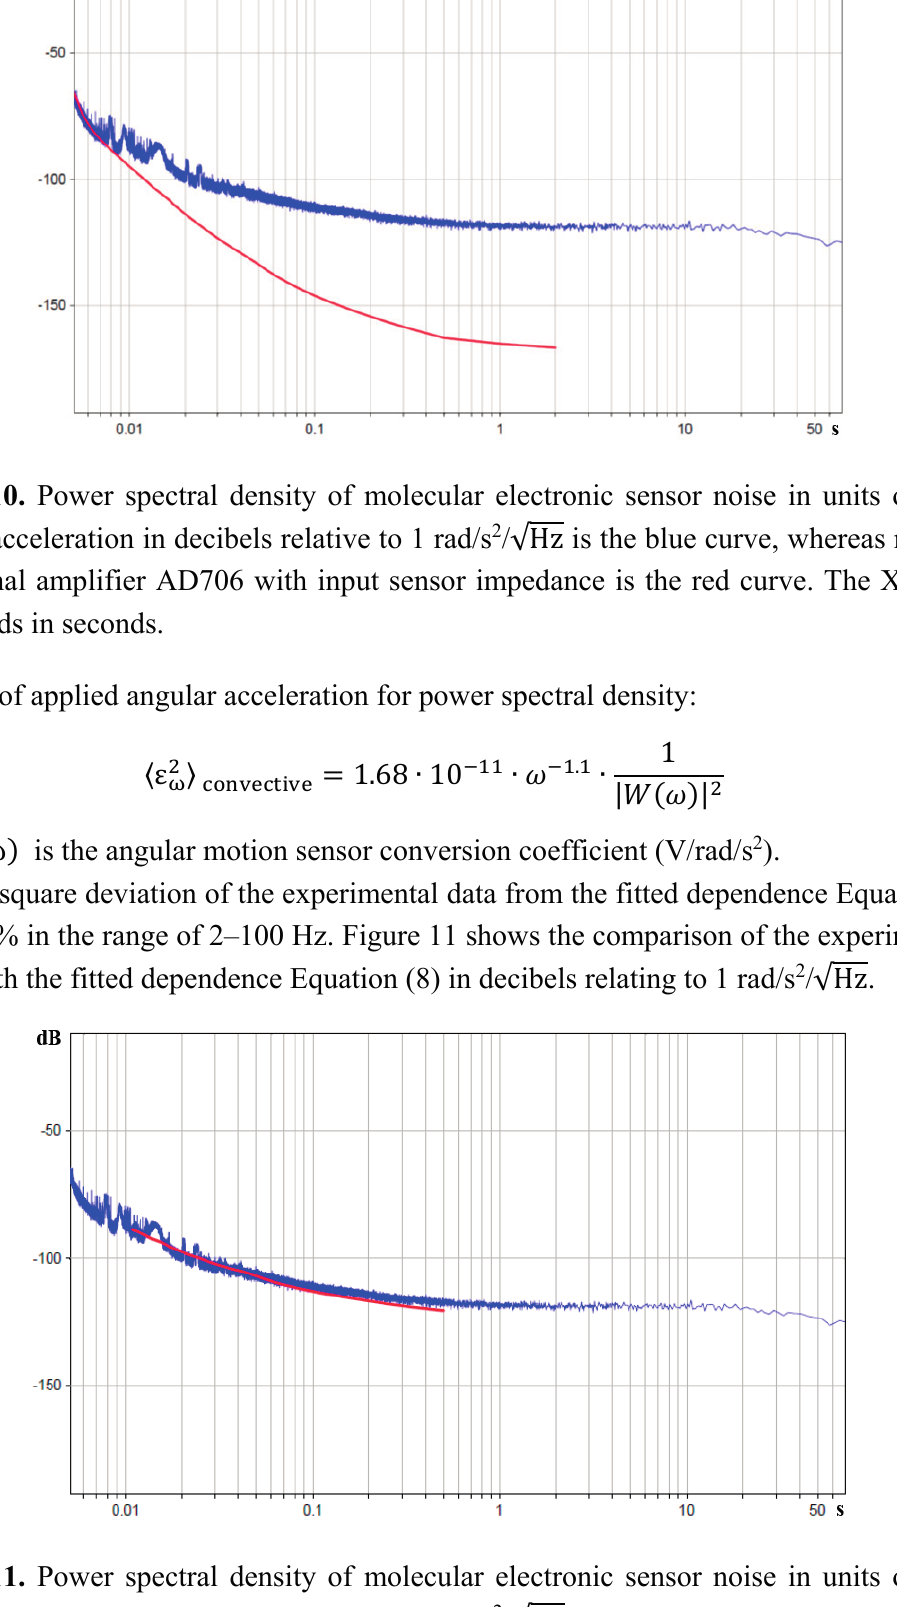
Figure 11. Power spectral density of molecular electronic sensor noise in units of input angular acceleration in decibels relative to 1 rad/s 2 / √Hz is the blue curve, theoretical curve corresponding to dependence Equation (7) is the red curve. The X-axis is the periods in